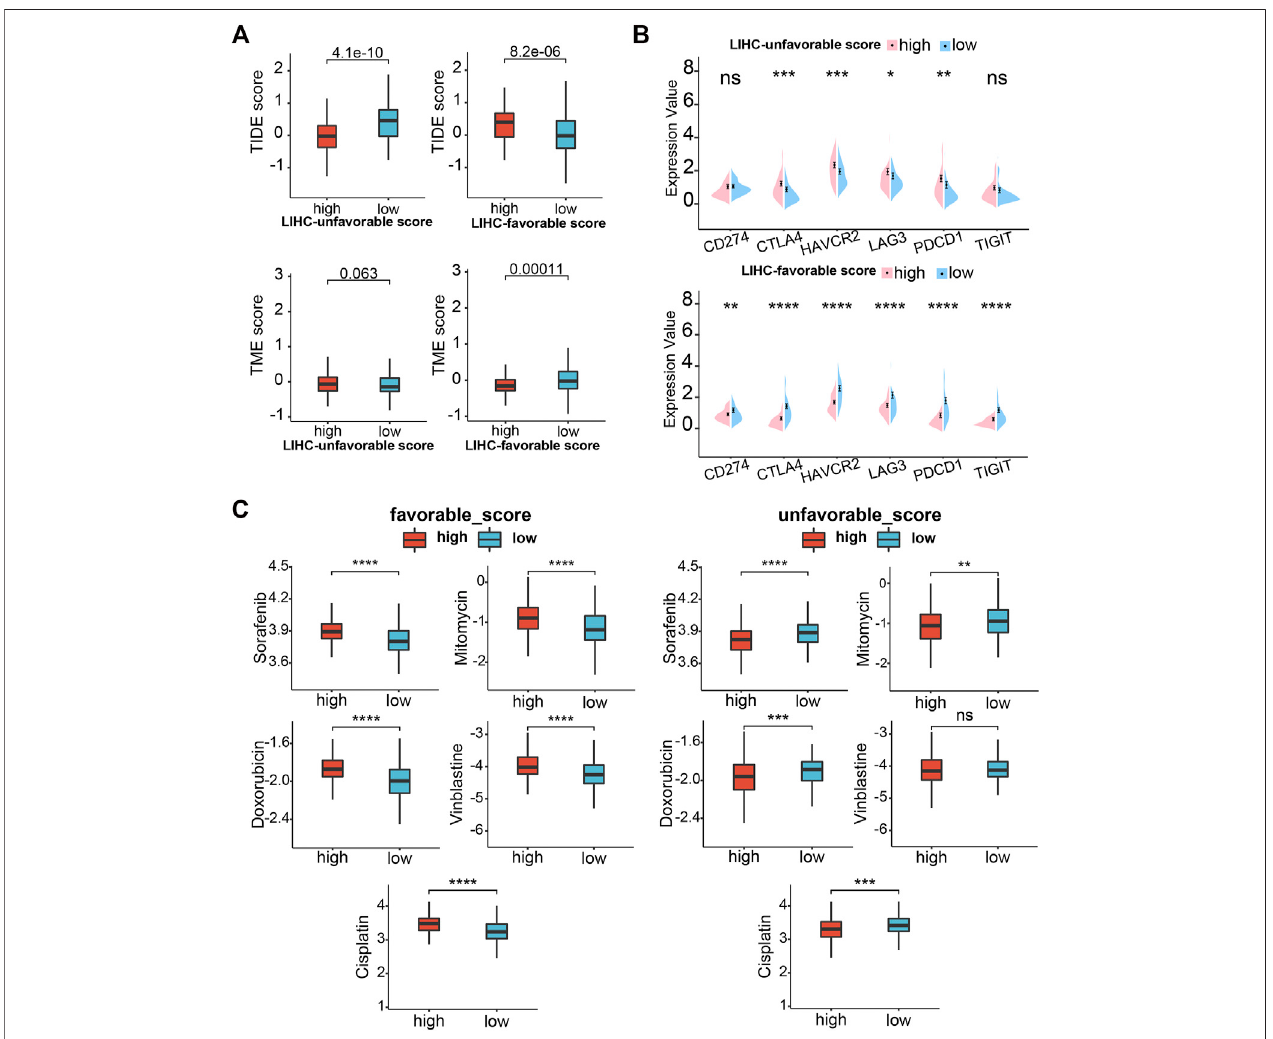
FIGURE11| Drug sensitivity analysis. (A) TIDEscoresand TMEscorebetweenhigh-and low-LUG/LFGscoregroup. (B) CorrelationanalysisoftwoGSVA scores and six immune checkpoint genes. (C) Relationships between chemotherapeutic sensitivity and both LFG score and LUG score. * p < 0.05, ** p < 0.01, *** p < 0.001, **** p <